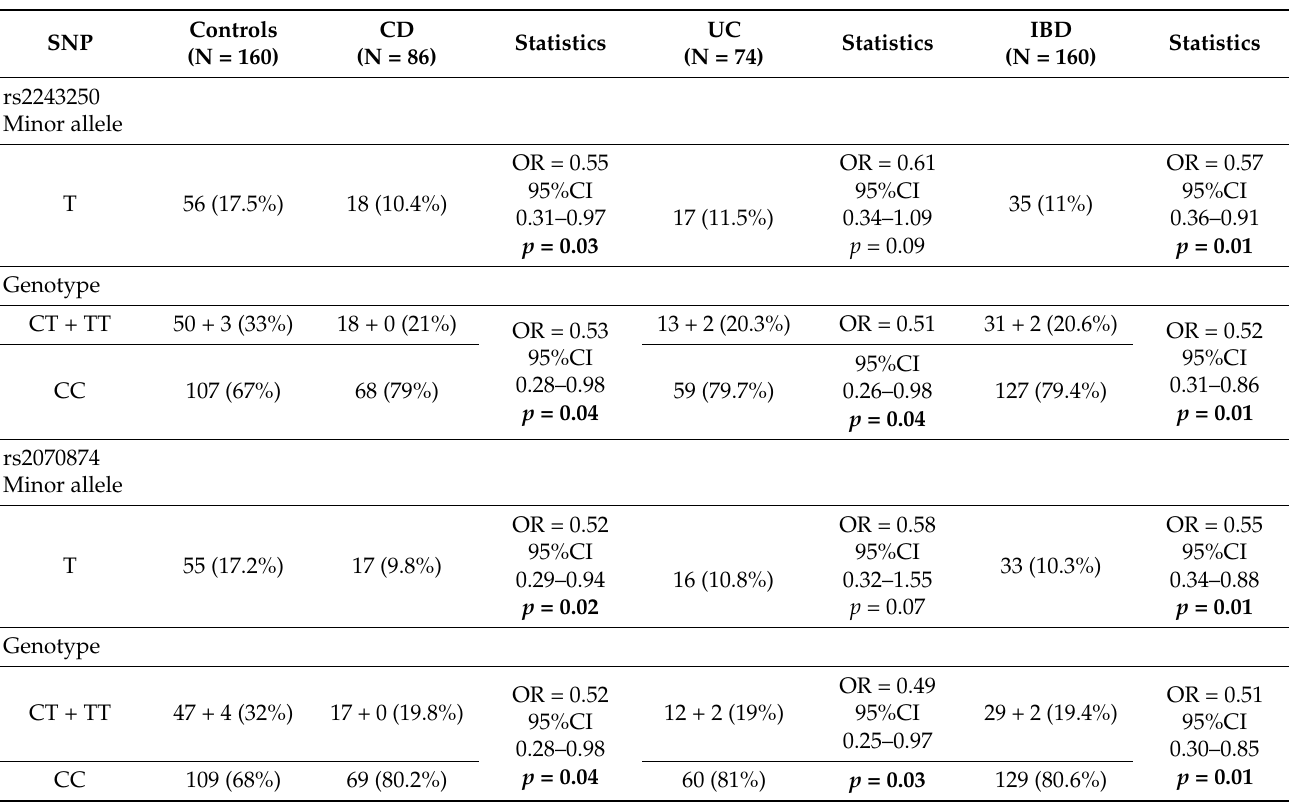
Table 3. Results of the association study of IL-4 single nucleotide polymorphisms and IBD groups.